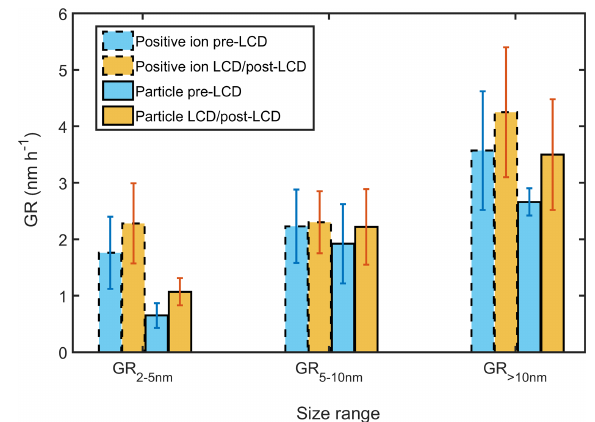
Figure 9. The mean values of growth rates of particles and ions in different size ranges, including 2–5nm (GR 2–5nm ), 5– 10nm (GR 5–10nm ), and > 10nm (GR > 10nm ), during pre-LCD and LCD + post-LCD, respectively. The histogram and error bars repre- sent the mean value and standard deviation,